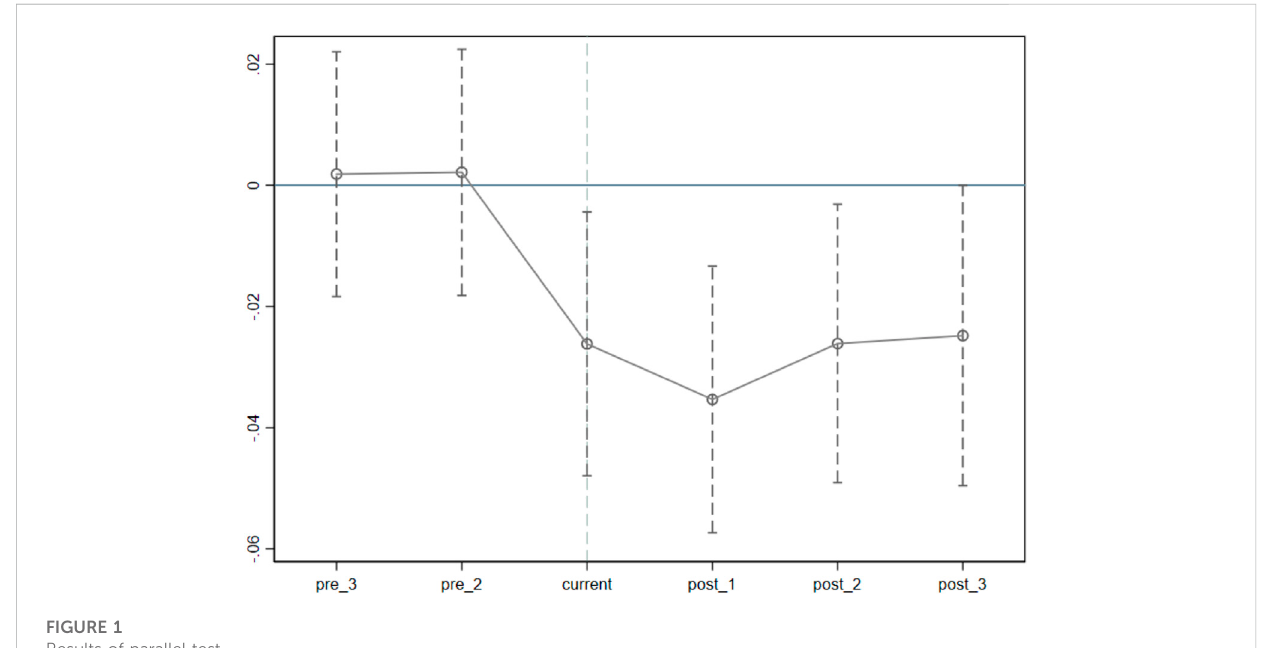
FIGURE 1 Results of parallel test.